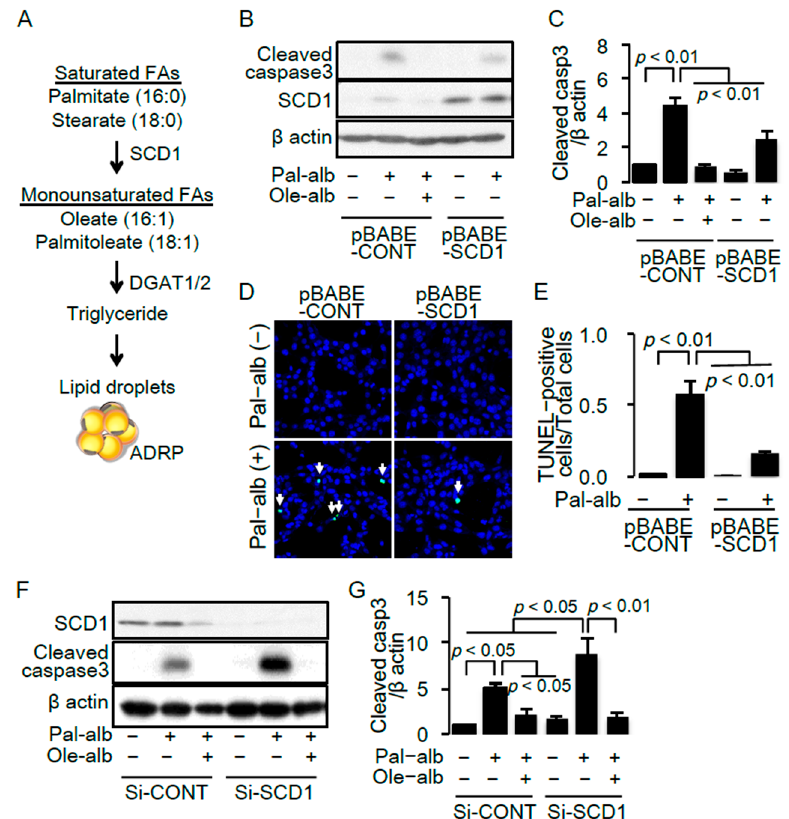
Figure 2. ( A ) Schema representing the formation of neutral lipid droplets from saturated free fatty acids (FAs) such as palmitate and stearate; ( B ) Representative immunoblot of cleaved caspase 3 and SCD1 in cultured proximal tubular cells infected with the control retrovirus (pBABE-CONT) or the retrovirus for SCD1 overexpression (pBABE-SCD1), and treated with/without palmitate or oleate. β -actin was used as a loading control; ( C ) Quantitative result of cleaved caspase 3 ( n = 5); ( D ) Representative pictures of TUNEL staining under the indicated conditions. White arrows indicate TUNEL-positive apoptotic cells; ( E ) Quantitative results of TUNEL staining; ( F ) Representative immunoblot of cleaved caspase 3 and SCD1 in cultured proximal tubular cells transfected with the control siRNA or siRNA against SCD1 , and treated with/without palmitate or oleate; ( G ) Quantitative result of cleaved caspase 3 ( n = 7). SCD, stearoyl-CoA desaturase. Data are shown as mean ± SD. p < 0.05 indicates statistical significance.